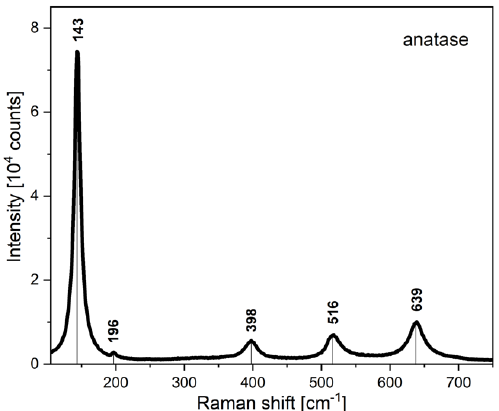
Figure 5. Raman spectrum of the magnetron sputtered TiO 2 electron blocking layer. The observed active vibrations are characteristic of anatase.